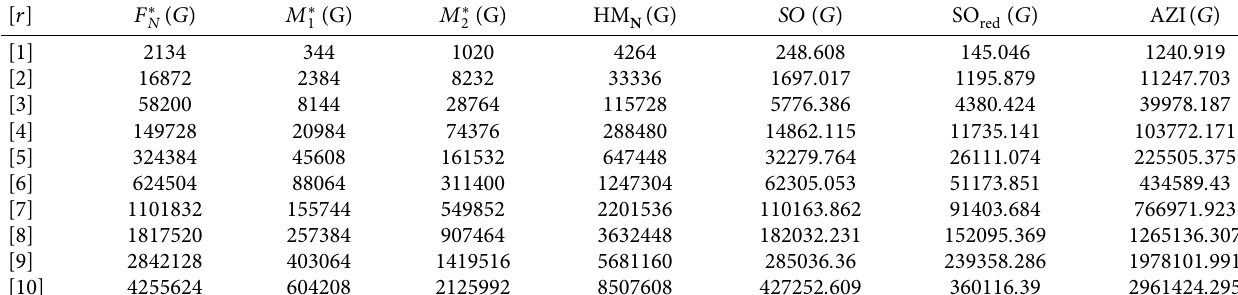
Table 2: Numerical table corresponding with the structure of the Sudoku graph.